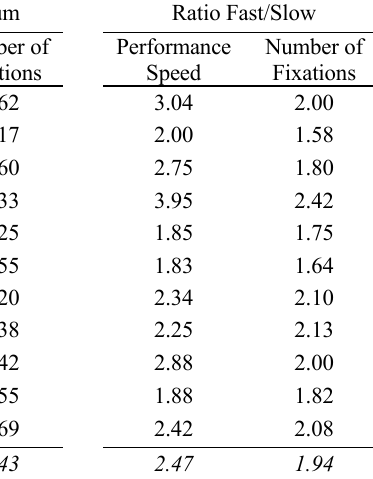
Table 2. Comparison of the ratios between different performance speeds (Slow, Medium and Fast) and the ratio for the number of fixations, for each performer for the C-Major scale exercise.